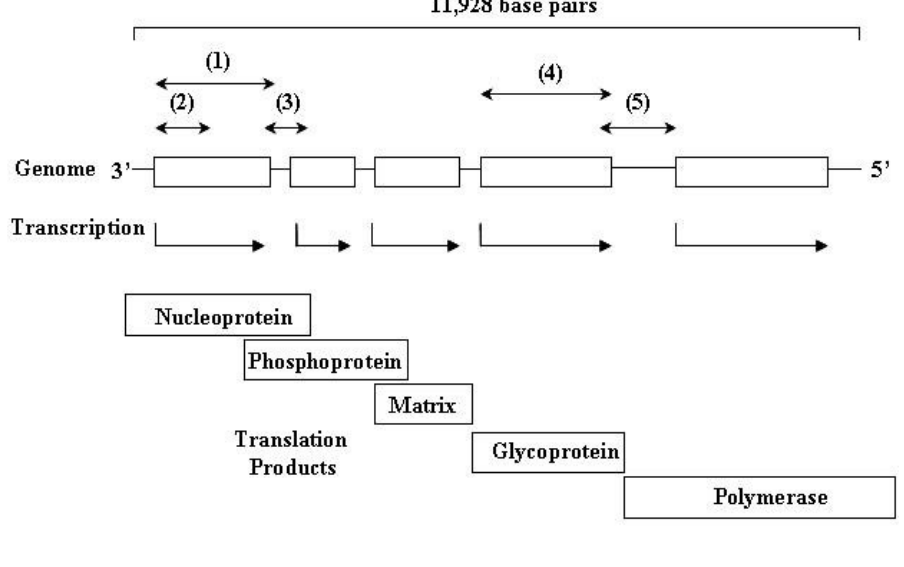
Figure 3. Schematic of the rabies virus genome showing transcription of the five genes to form the nucleoprotein, phosphoprotein, matrix, glycoprotein and polymerase or L gene. Sections of the genome that are commonly used for phylogenetic analysis of rabies viruses are indicated: (1) Complete nucleoprotein coding sequence; (2) partial nucleoprotein coding sequence; (3) nucleoprotein-phosphoprotein intergenic region; (4) complete glycoprotein coding sequence; (5) glycoprotein-L intergenic